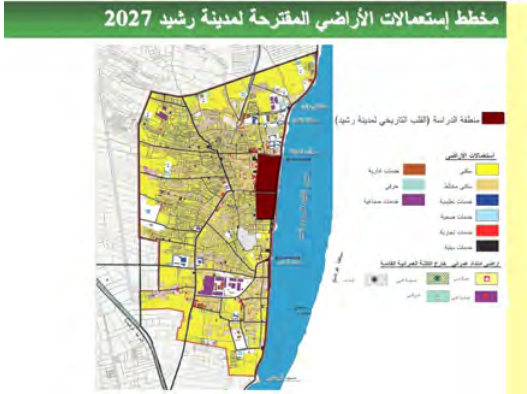
Figure 21. (Strategic Master Plan of Rashid city-2010)